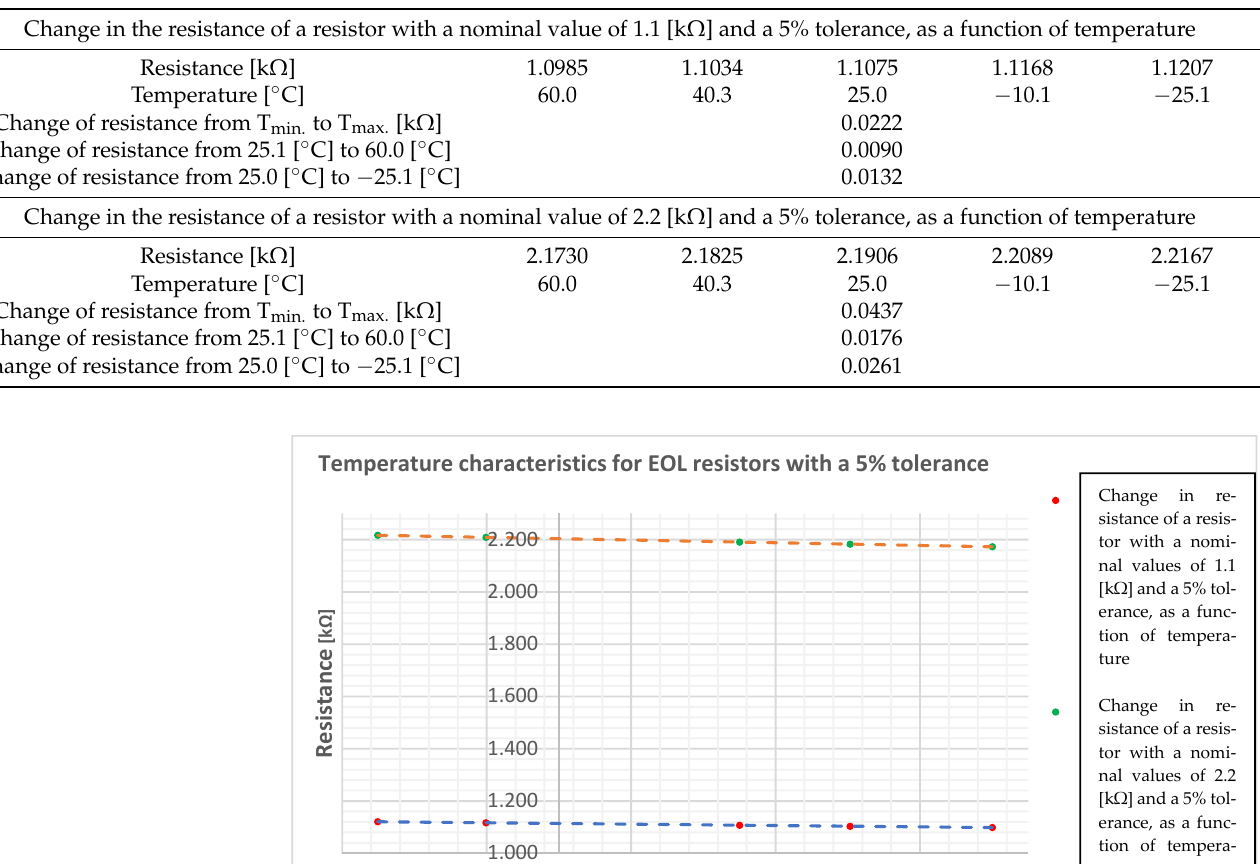
Table 1. Results for the measurement of temperature characteristics of EOL resistors with the nominal values of 1.1 [k Ω ] and 2.2 [k Ω ].